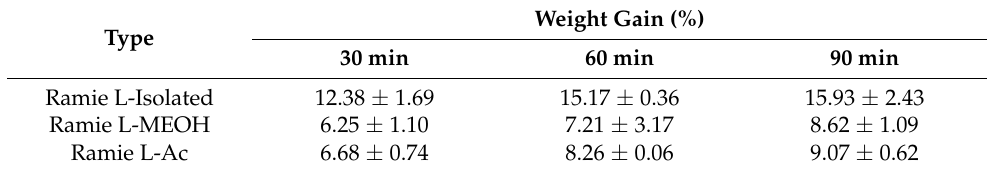
Table 5. Weight gain of ramie fiber after impregnation with lignin-based Bio-PU at 30, 60, and 90 min. Type